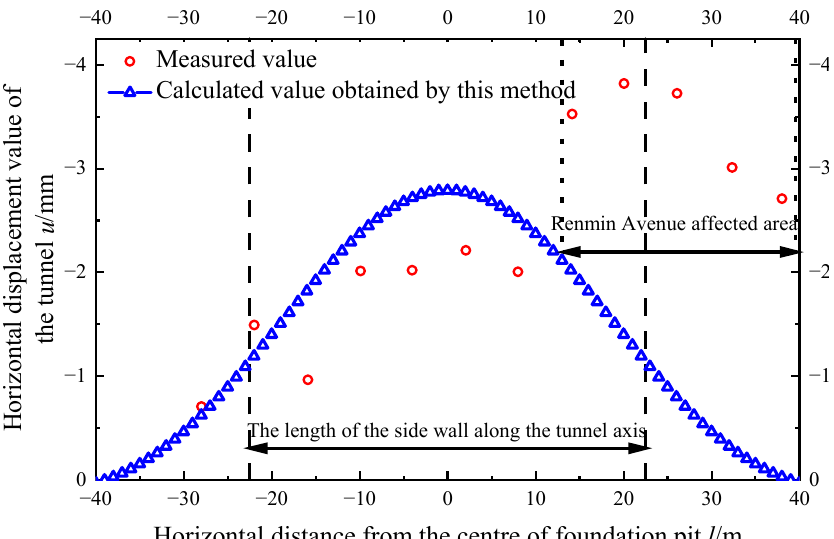
Figure 8. Comparison of the calculated and measured values of the horizontal displacement of the tunnel beside the foundation pit in case 1.